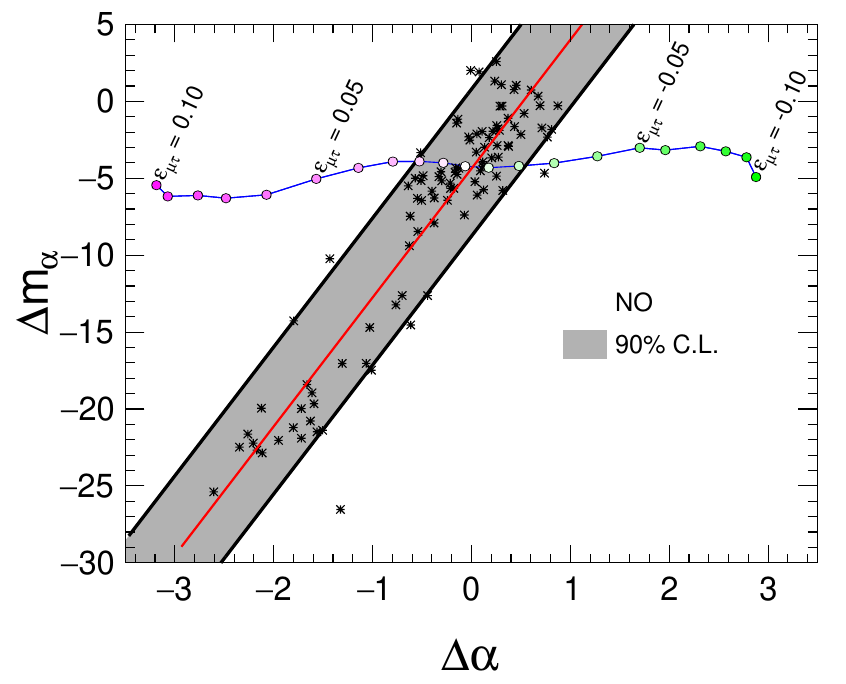
Figure 11 . The blue curve with colored circles shows the calibration of ε µτ in the (∆ α, ∆ m α ) plane, obtained from 1000-year MC. The black stars are the values of (∆ α, ∆ m 100 independent data sets, each for 10 years data of ICAL, when ε the expected 90% C.L. region in this plane for a 10-year exposure at ICAL, when ε part of the blue calibration line covered by the gray band gives the expected 90% C.L. bounds on ε µτ . We consider normal mass ordering, and the benchmark oscillation parameters given in table 2.